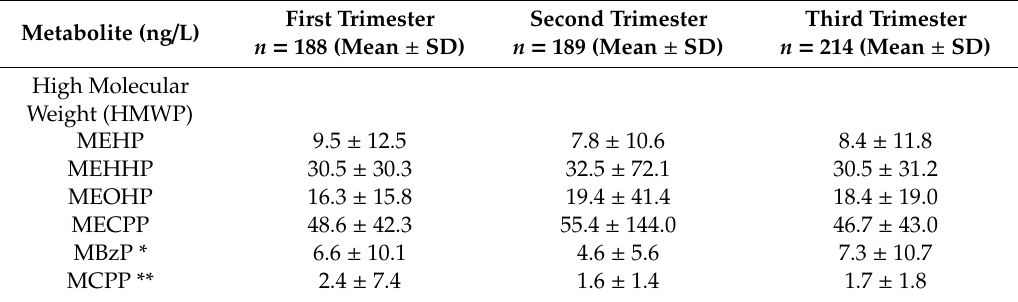
Table 2. Urinary phthalate metabolites geometric mean levels per trimester, adjusted for specific gravity. Metabolite (ng / L)